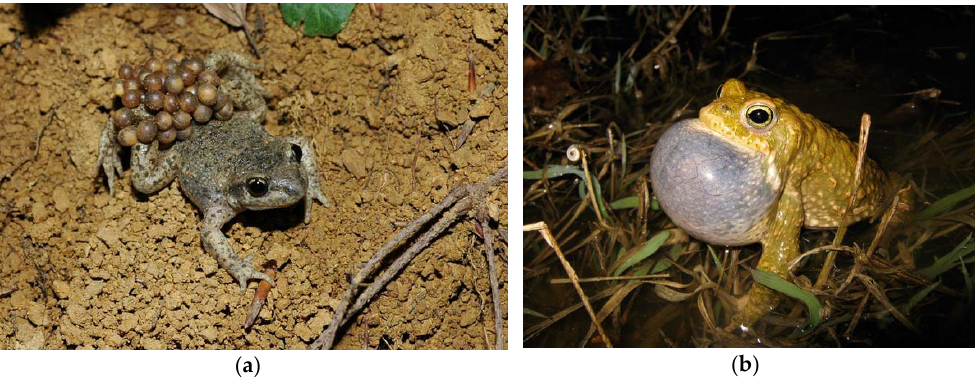
Figure 8. Two specific anuran species: ( a ) Alytes obstetricans toad, carrying egg strings [35]; ( b ) Epidalea calamita toad [36]. Photographs by Ursina Tobler.